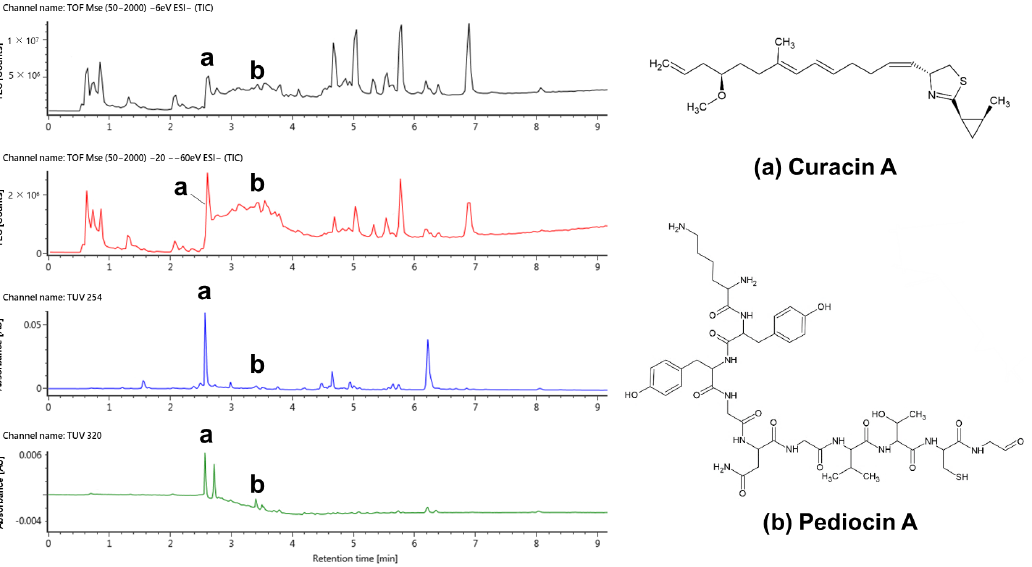
Figure 6. UP LC-QTOF-MS chromatogram of cell-free supernatant from P. inopinatus K35. ( a ) Curacin A. ( b ) Pediocin